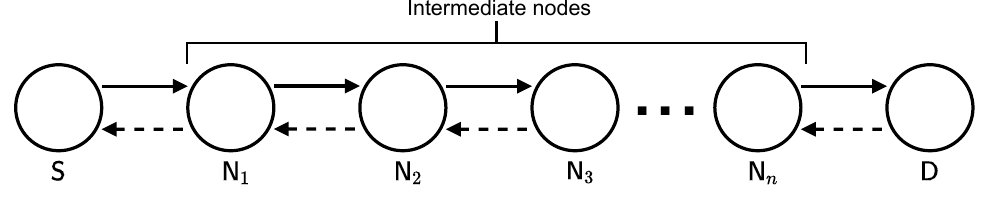
Figure 1. Network